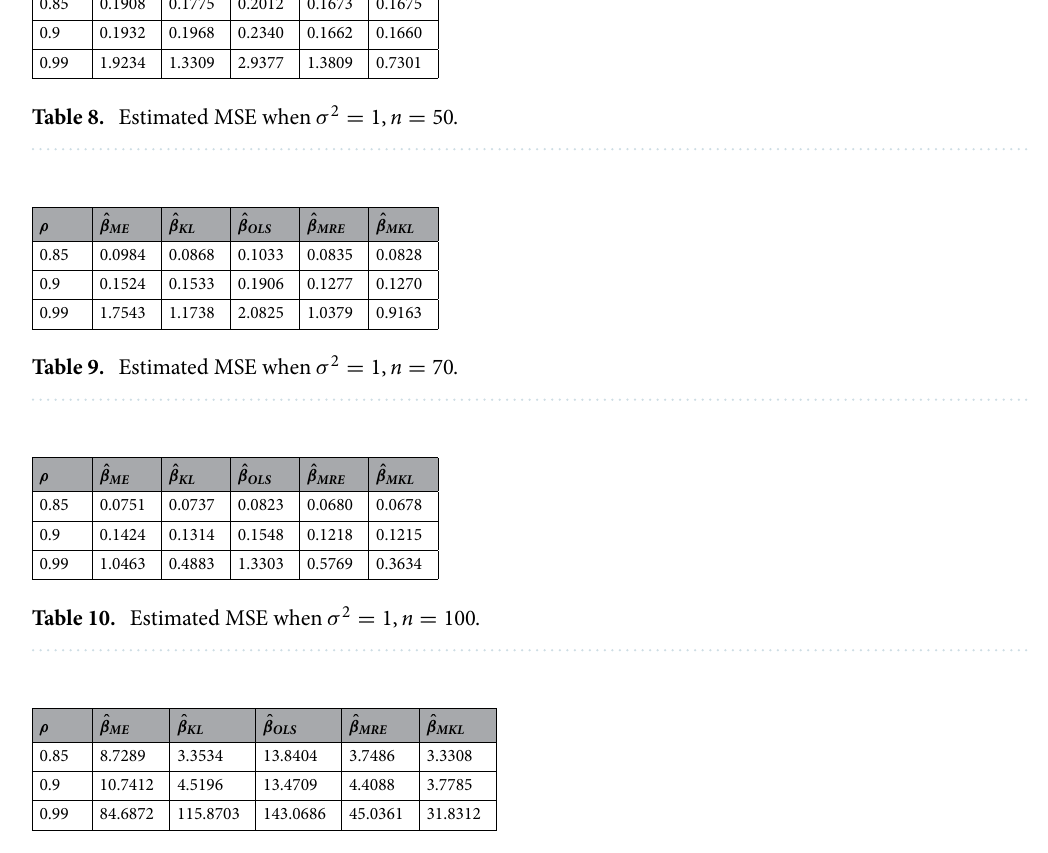
Table 11. Estimated MSE when σ